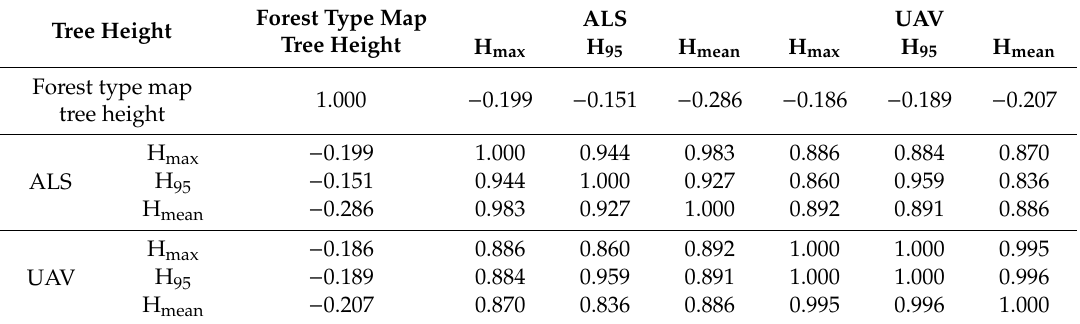
Table 12. Tree height correlations among ALS, UAV, and Forest type map. Tree